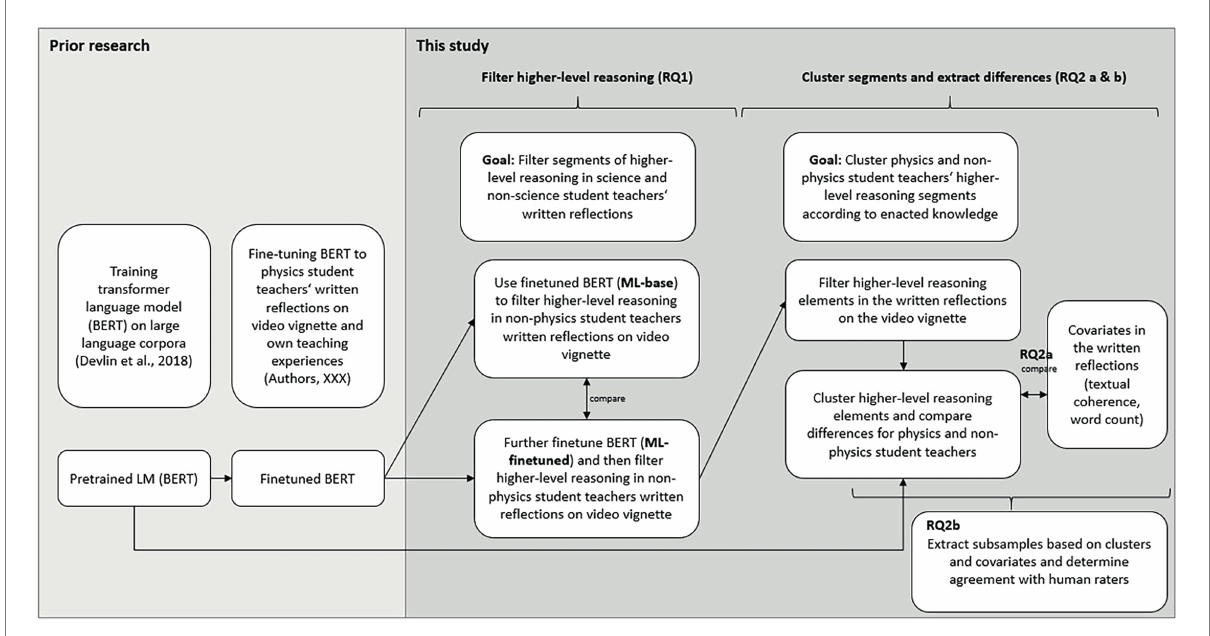
FIGURE 1 Overview of research process to answer RQ1 and